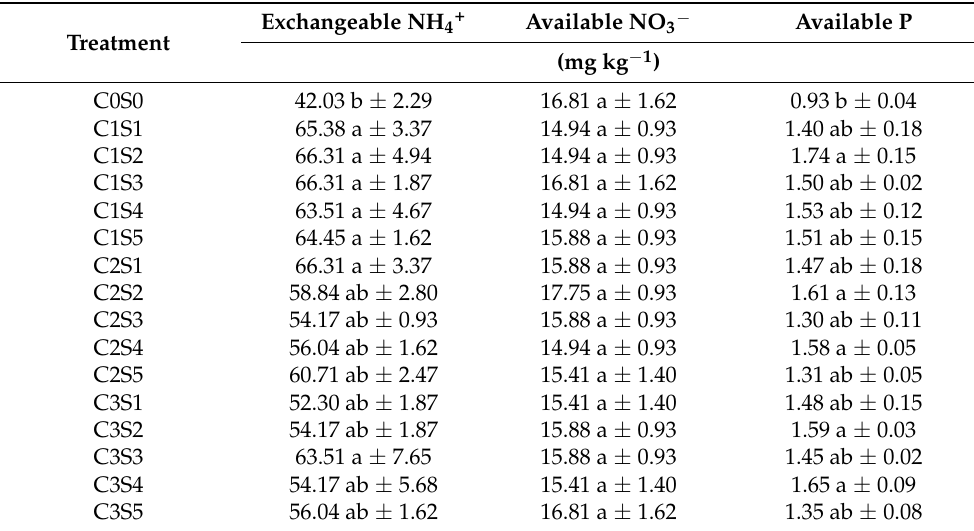
Table 5. Mean soil exchangeable ammonium, available nitrate, and available phosphorus for the different treatments after thirty days of